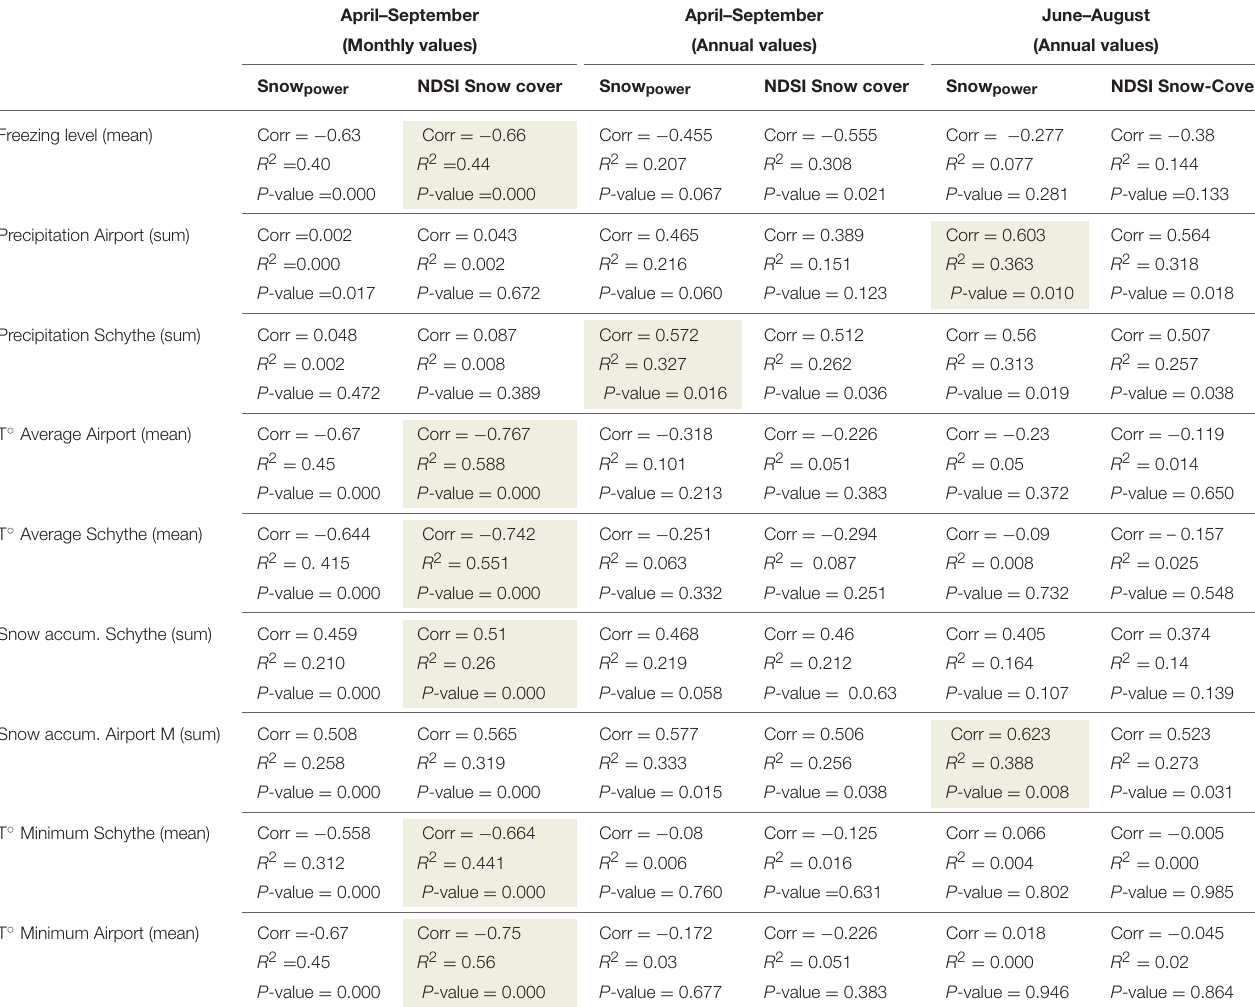
TABLE 2 | Result of the different linear regressions between Snow power index and NDSI snow cover (km 2 ) for the Macro zone, with the Punta Arenas Airport freezing level from radiosonde data, precipitation (mm), minimum, and mean temperature (monthly averages) from Punta Arenas Aiport and Jorge Schythe stations, for